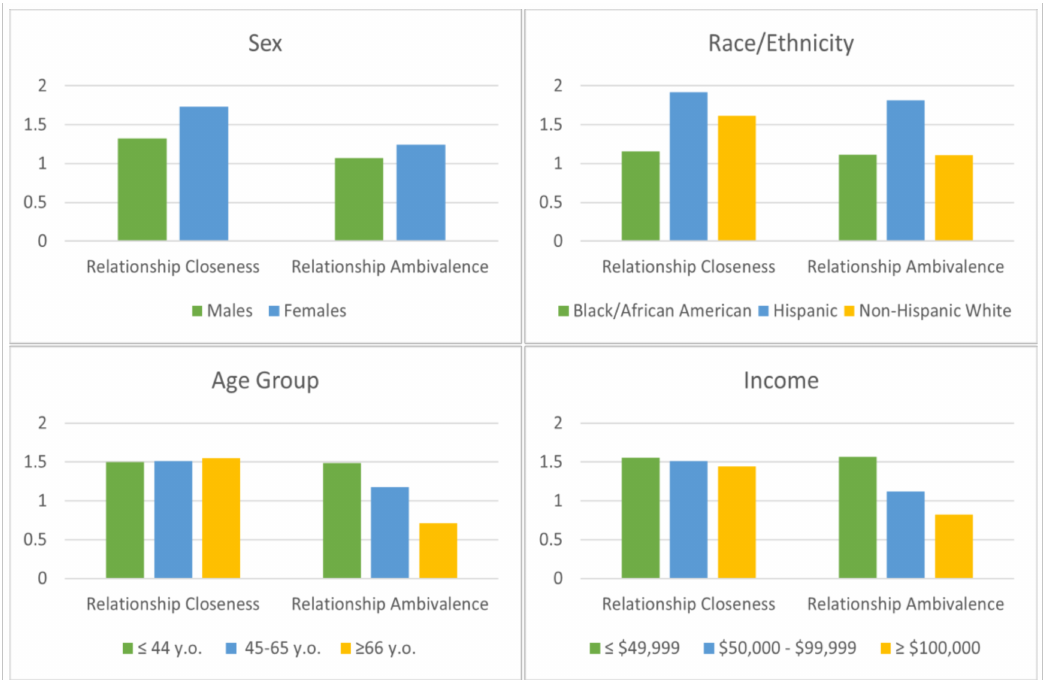
Figure 1. Mean scores for relationship closeness and ambivalence by key sociodemographic